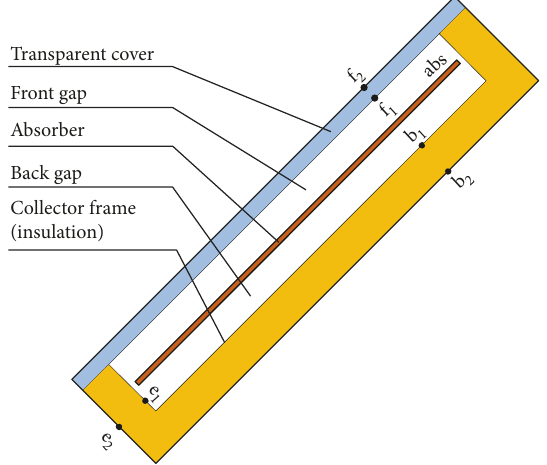
Figure 4: The main collector planes (surfaces) in a solar collector